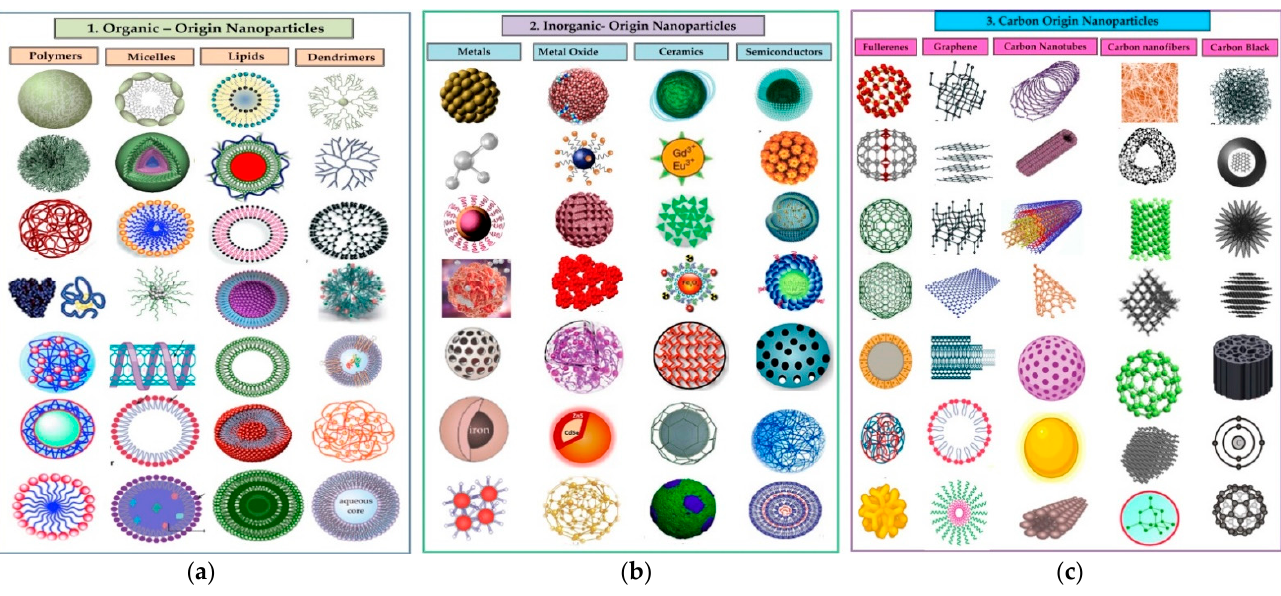
Figure 2. Size and shape of different types of NPs: ( a ) polymers, micelles, lipids, and dendrimers belonging to organic-origin NPs; ( b ) metals, metals oxide, ceramics, semiconductors belonging to inorganic-origin NPs; ( c ) fullerenes, copolymer, carbon nanotubes, carbon nanofibers, and carbon black belonging to carbon-origin NPs (idea adapted from the ref [46]).